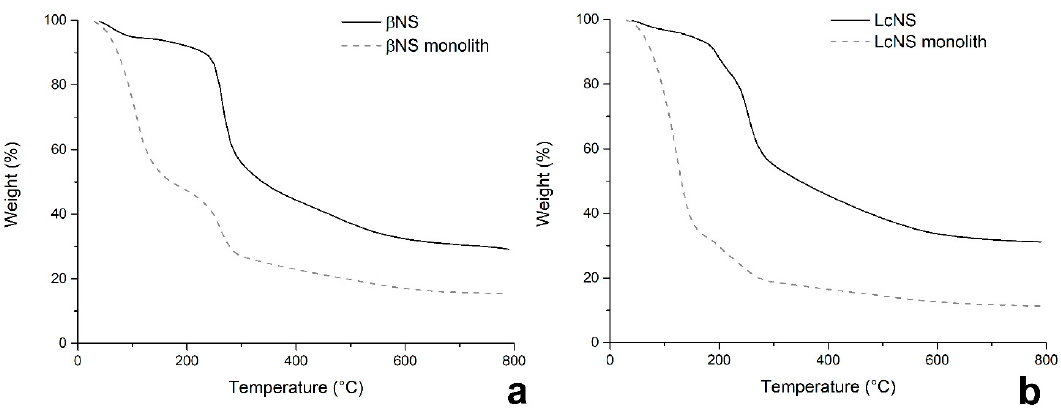
Figure 7. TGA of β NS ( a ) and LcNS ( b ).